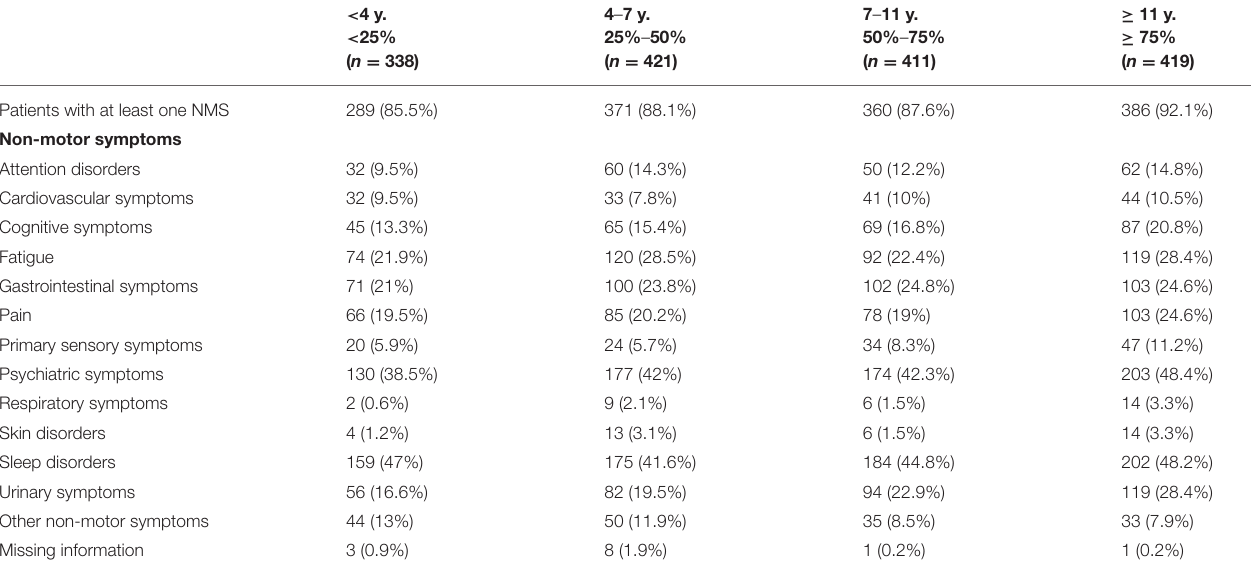
TABLE 5 | Distribution of non-motor symptoms in idiopathic Parkinson’s disease blocking for “years from diagnosis”